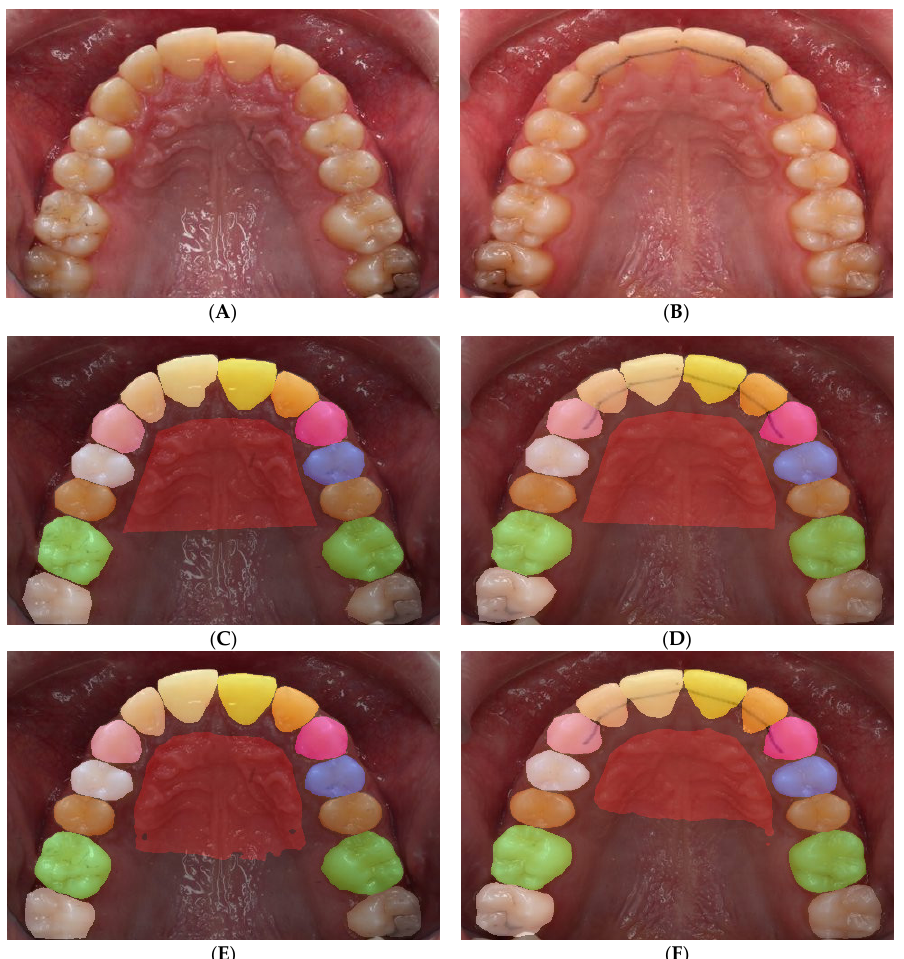
Figure A2. The first column shows the original image ( A ) from the pre-treatment set, followed by its ground truth label ( C ) in the second row, and its prediction from the model in the third row ( E ). The second column shows the same order for an image as for the post-treatment of the same patient ( B , D , F ).